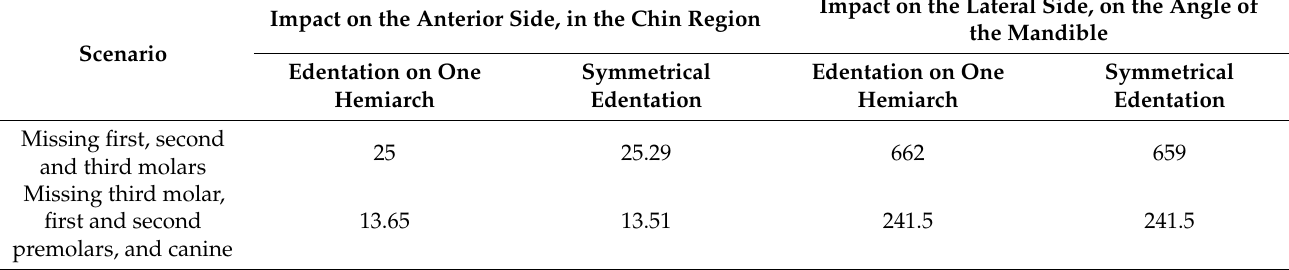
Table 3. Comparative stress values [MPa].